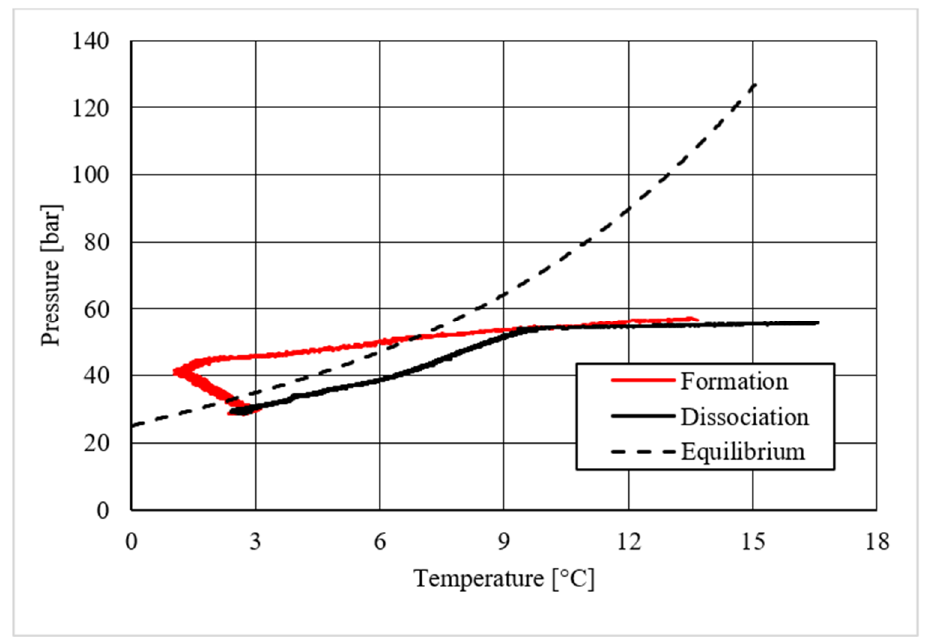
Figure 9. Pressure and temperature trends over time, measured for methane hydrate formation in presence of 18.01 wt% CuSn12 powder.